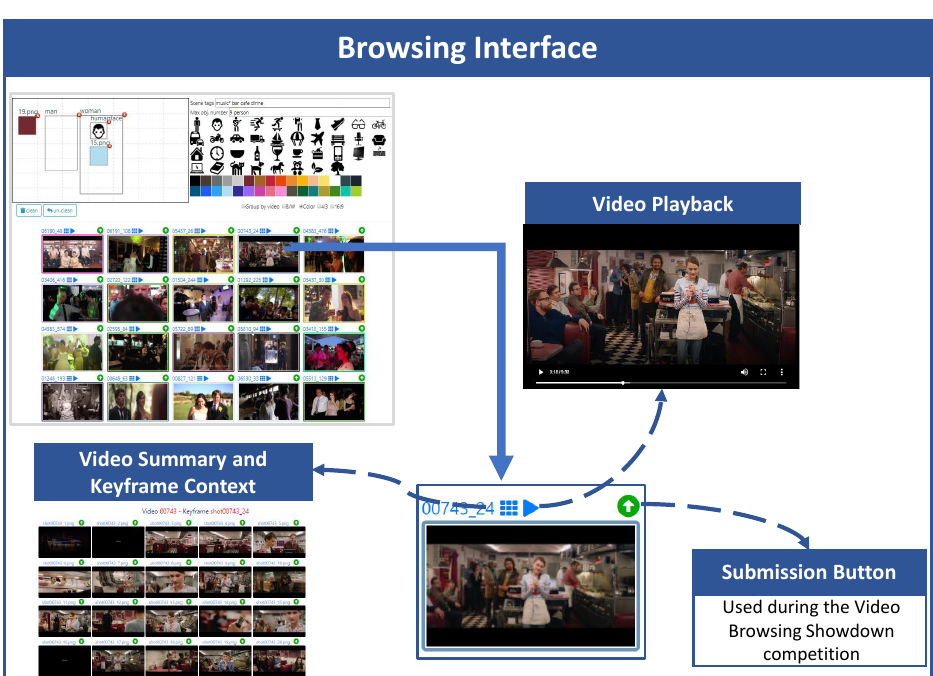
Figure 4. An highlight of the Browsing Interface: for each keyframe result it allows accessing the information such as video summary, keyframe context, play the video starting from the selected keyframe and search similar